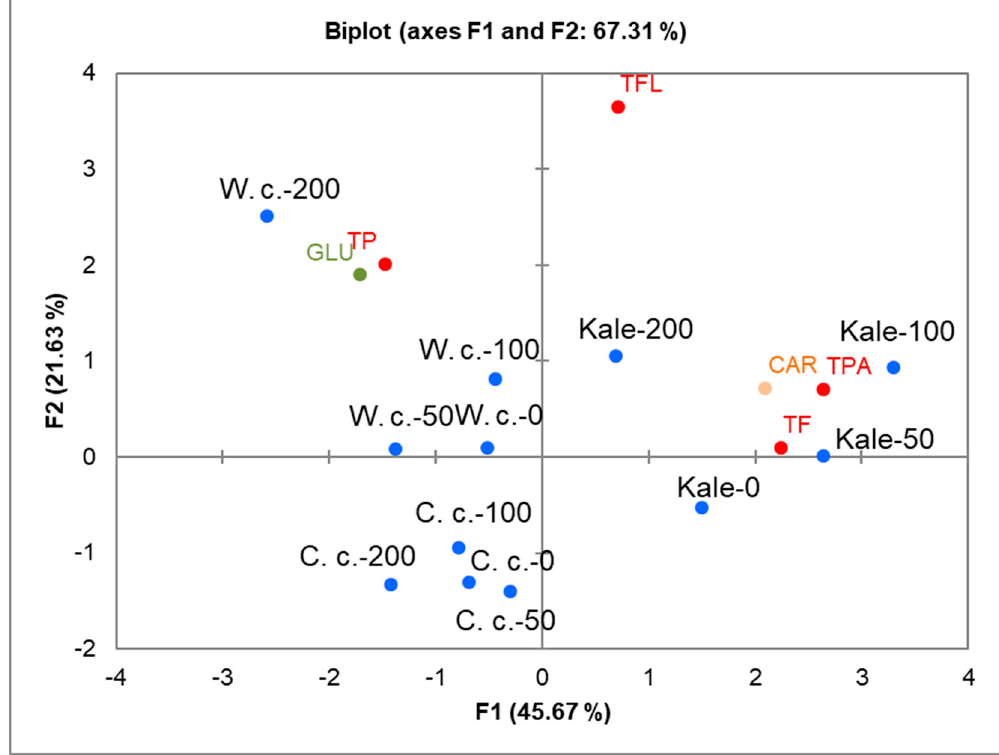
Figure 4. Two-dimensional principal component analysis (2D-PCA) of specialized metabolites in Chinese cabbage (C. c), white cabbage (W. c.), and kale (Kale) after 24 h exposure to 0 (control), 50, 100, and 200 mM NaCl. The green, orange, and red symbols indicate the positions in the score plots of glucosinolates (GLU), carotenoids (CAR), and phenolic compounds (total phenolics (TP), total flavonoids (TF), total phenolic acids (TPA), total flavonols (TFL)), respectively. The blue symbols indicate the positions of the Brassica crops following each of the treatments. PCA was created based on data presented in Supplementary Table S1. The correlation matrix used, eigenvalues, factor loadings, and factor scores are given in Supplementary Tables S2–S6.